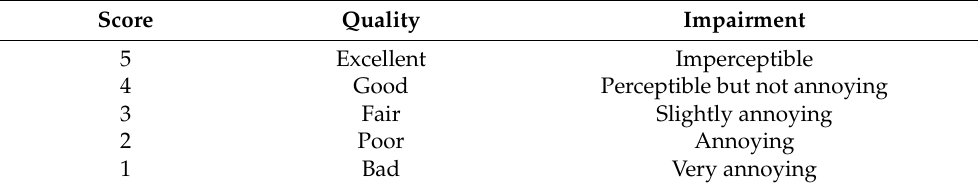
Table 1. Mean Opinion Score (MOS) for the qualitative image analysis.